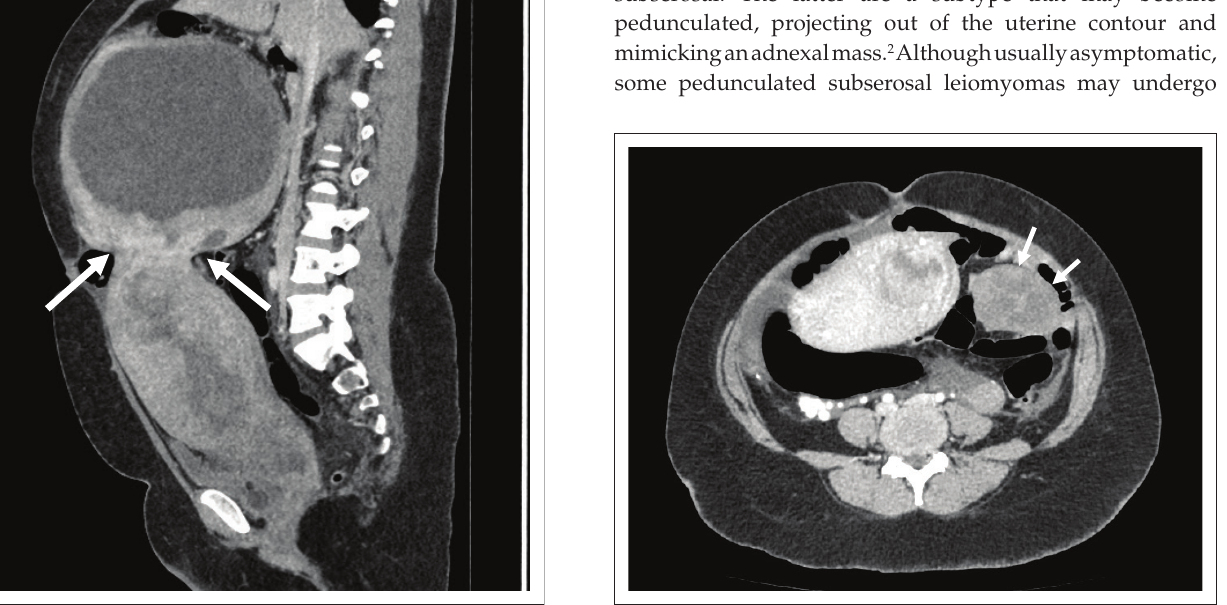
FIGURE 2: Sagittal portal venous computed tomography shows that the mass is connected to the uterine fundus (arrows).